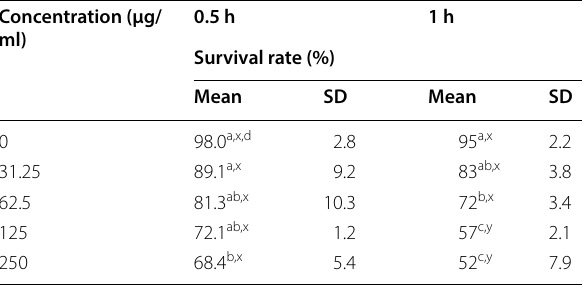
a–c Means within a column with no common superscript are significantly different ( P